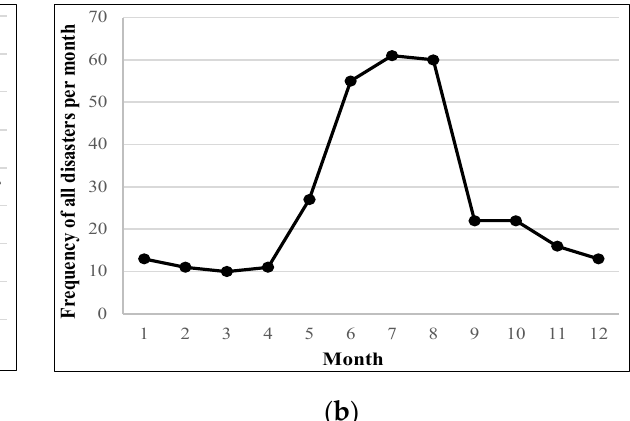
Figure 5. Proportional Distribution of Railway Geological Hazards. Figure 6a is the inter-annual frequency statistics of railway disastrous accidents caused by geological hazards, and the frequency of geological hazards along the railway has shown an upward trend over the years. The geological hazards along the railway have increased significantly in the 2010–2021 period, which may be caused by the increased railway network coverage and higher frequency of extreme weather. Figure 6b provides the statistics on the monthly frequency of geological hazards along the railway. The geological hazards along the railway mainly happen in June, July and August, with a significant concentration. The main reason is that the occurrence of geological hazards along the railway is closely related to precipitation. China is in the monsoon region, with concentrated precipitation and rainstorms in summer. The precipitation in summer accounts for 56.5% of the national average annual precipitation [59]. Continuous rainfall and rainstorms have caused large-scale and frequent geological hazards in weak strata, unstable slopes and loosely structured gully areas, so as to trigger disastrous railway accidents.